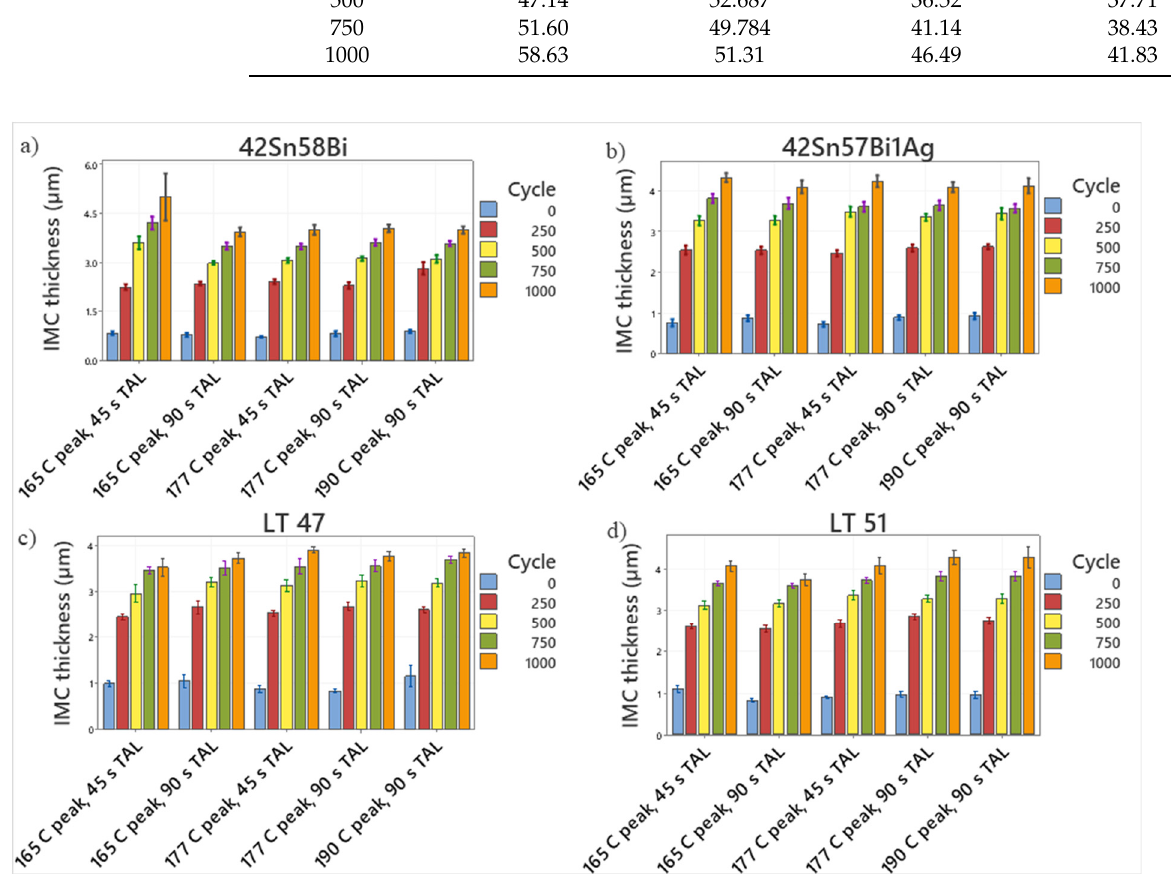
Figure 18. Charts plotting the evolution of the IMC layer as a function of cycles for ( a ) 42Sn58Bi, ( b ) 42Sn57Bi1Ag, ( c ) LT 47 and ( d ) LT 51.